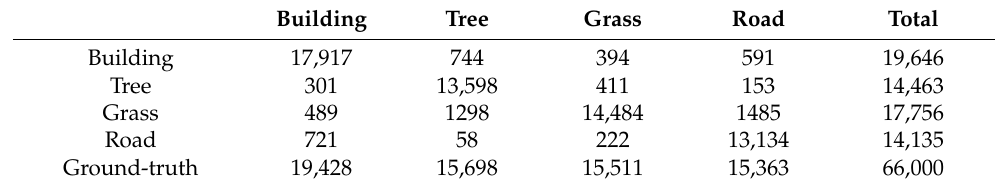
Table 9. Confusion matrix on test set